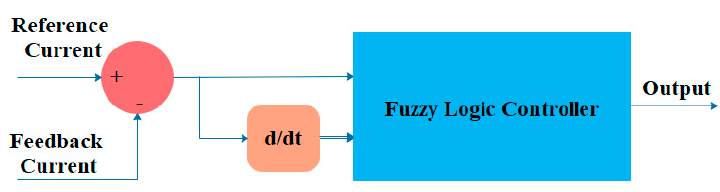
Figure 32. Current control block using fuzzy logic.